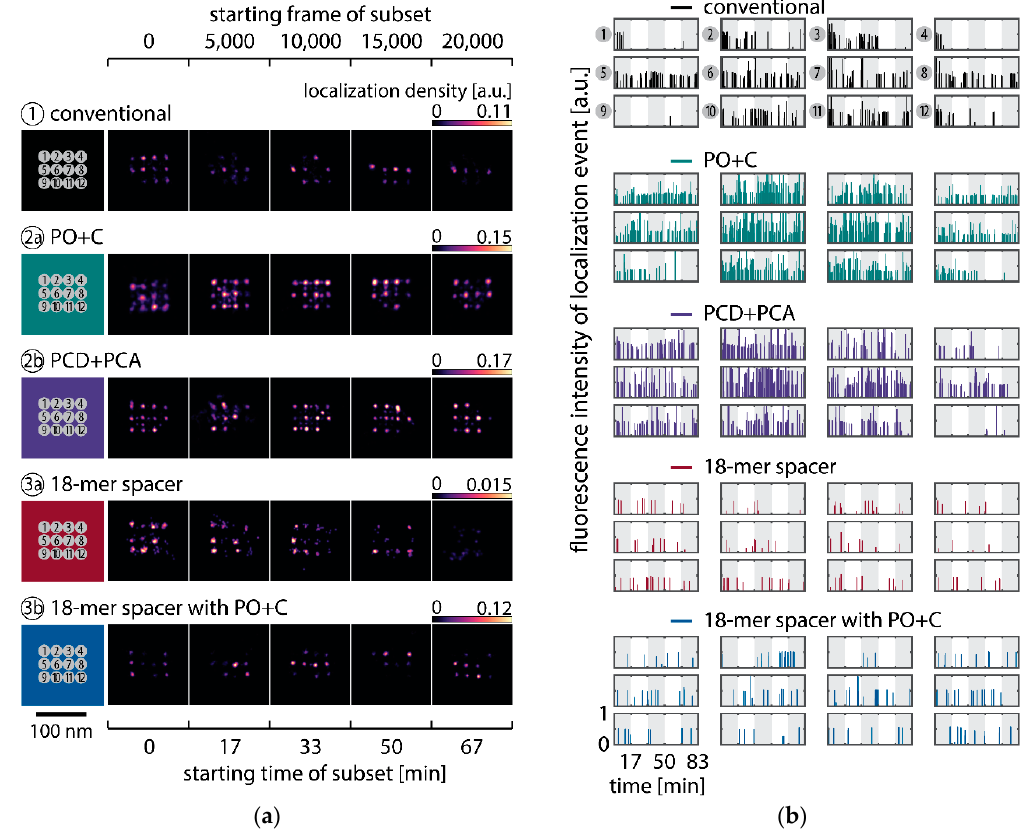
Figure 2. Long DNA-PAINT acquisition of DNA origami nanostructures with 12 exposed docking strands arranged in a 3 × 4 grid with 20 nm spacing. Five conditions are displayed: conventional imager (1, black), conventional imager with oxygen scavenging system added (2a: PO+C, turquoise; 2b: PCD+PCA, purple), imager with 18-mer spacer between docking sequence and fluorescent dye (3a, red) and the 18-mer spacer with PO+C (3b, blue). (a) Time series of representative super-resolved DNA-PAINT images, reconstructed from five subsequent 5,000 frame long subsets of a 25,000 frame long acquisition (in total 83 min). Additional examples are listed in the appendix (Figure A3). Scale Bar: 100 nm. (b) Time traces of localizations within circular areas picked as individual bindings sites. The alternating shade of the background indicates the five subsets. DNA-PAINT raw data is available as supplementary material.